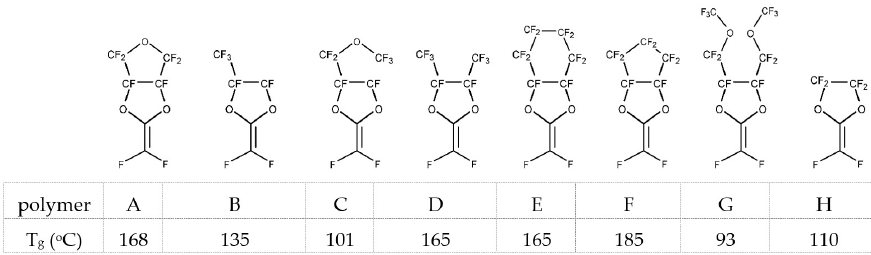
Figure 3. Chemical structures of perfluorodioxolane monomers and T g of their polymer.